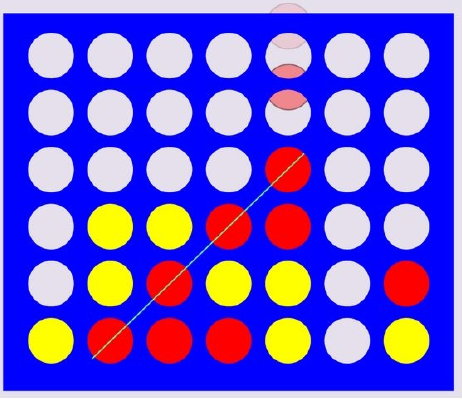
Figure 2. Illustration of Connect Four with a 7 × 6 board (adopted from